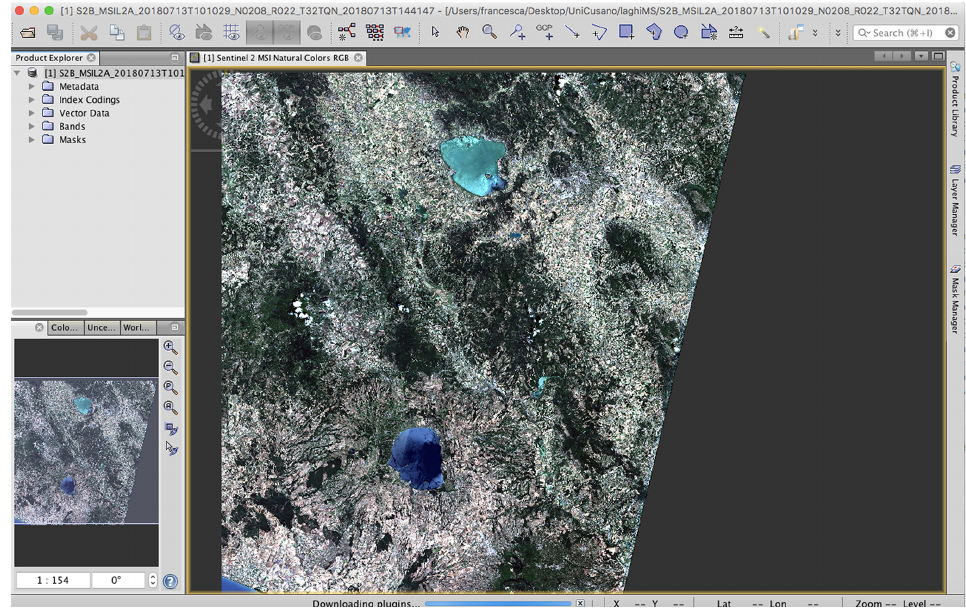
Figure 5. Example of Sentinel-2 imagery in SNAP